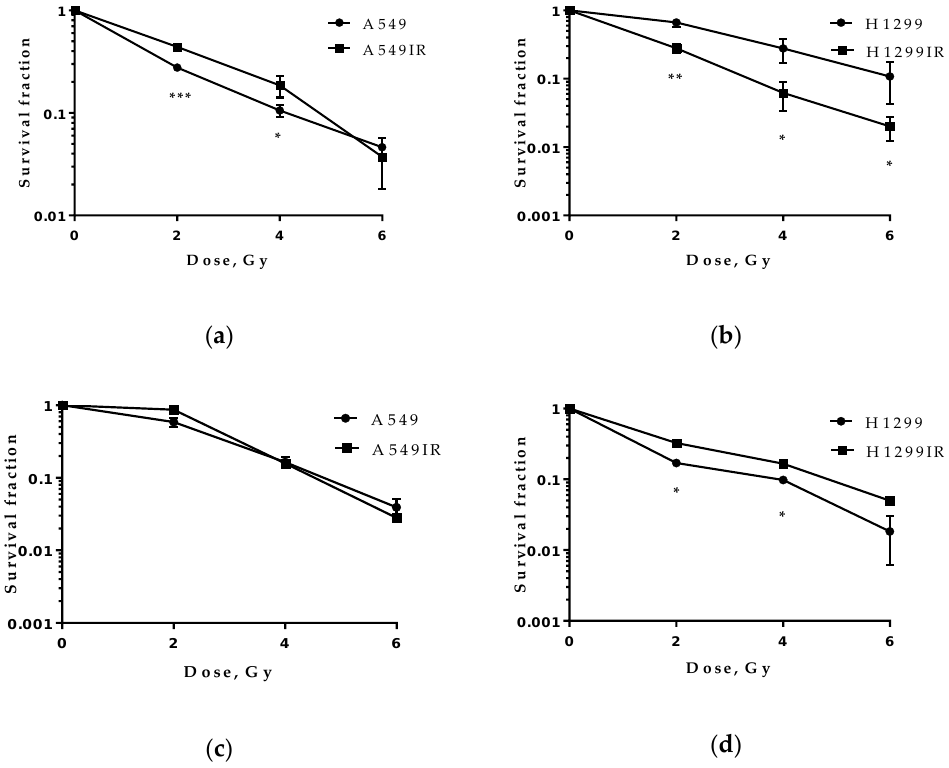
Figure 1. Radiosensitivity of A549 and A549IR cells and H1299 and H1299IR cells after X-ray exposures evaluated by colony formation assay ( a , b ) and soft agar assay (anchorage-independent growth) ( c , d ). * p < 0.05, ** p < 0.01; *** p < 0.001. Data are means ± SD of three independent experiments.